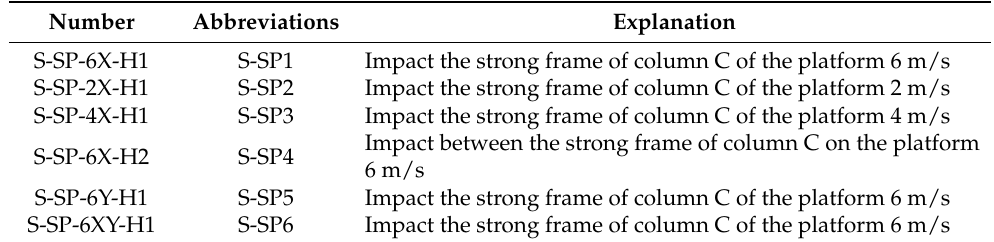
Table 1. The introduction of the collision